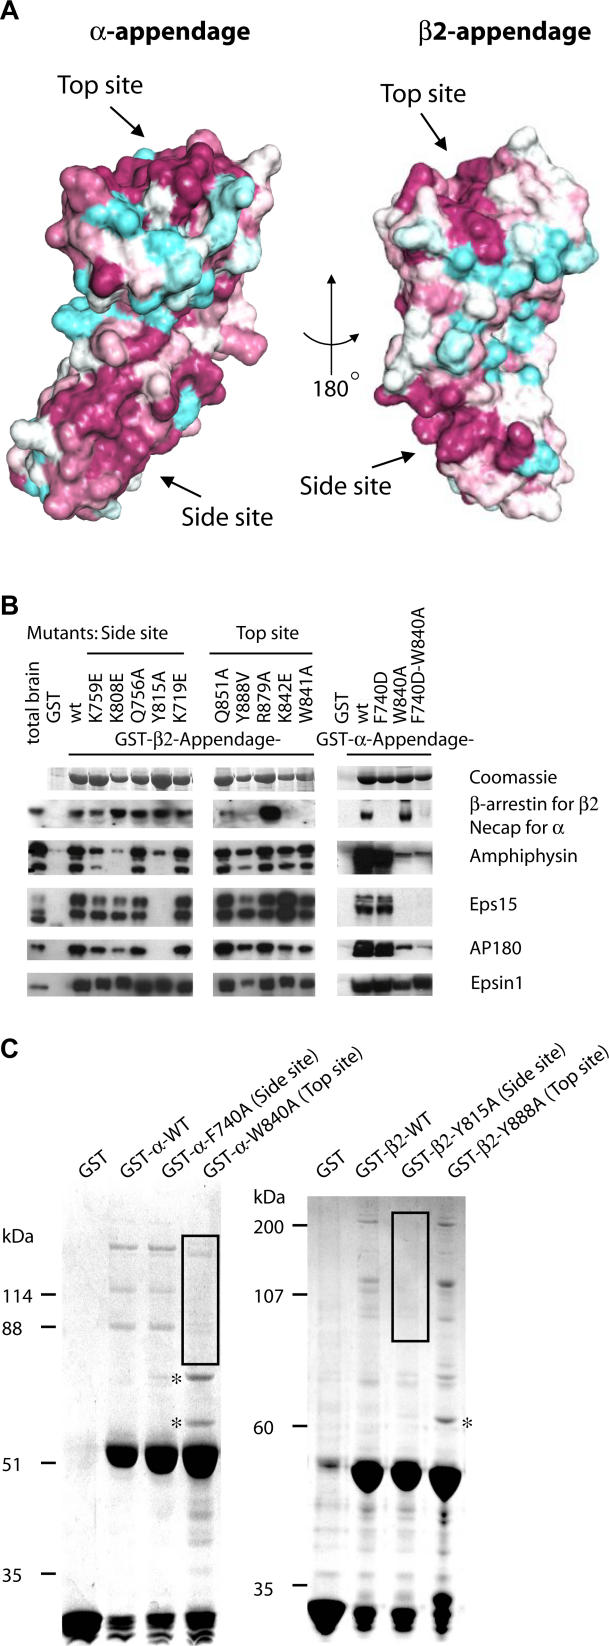
The β2-Appendage Has Top and Side Sites for Protein Interactions(A) Surface residues that are conserved from yeast to man are coloured from maroon (highly conserved) through white to sky-blue (least conserved). The α-appendage is shown for comparison. Both have two conserved patches, a top site and a side site.(B) Mutants of top and side sites in β compared with mutants of α. GST wild-type and mutant appendages were used in pull-downs from brain extract. β-arrestin binds specifically to the top site of β2, while most other ligands appear to bind more tightly to the side site.(C) Coomassie gel analysis of protein interactors with α- and β2-appendages from brain extracts. The boxed areas show the most effective mutants at displacing ligands. Asterisks mark positions of co-purified chaperones.